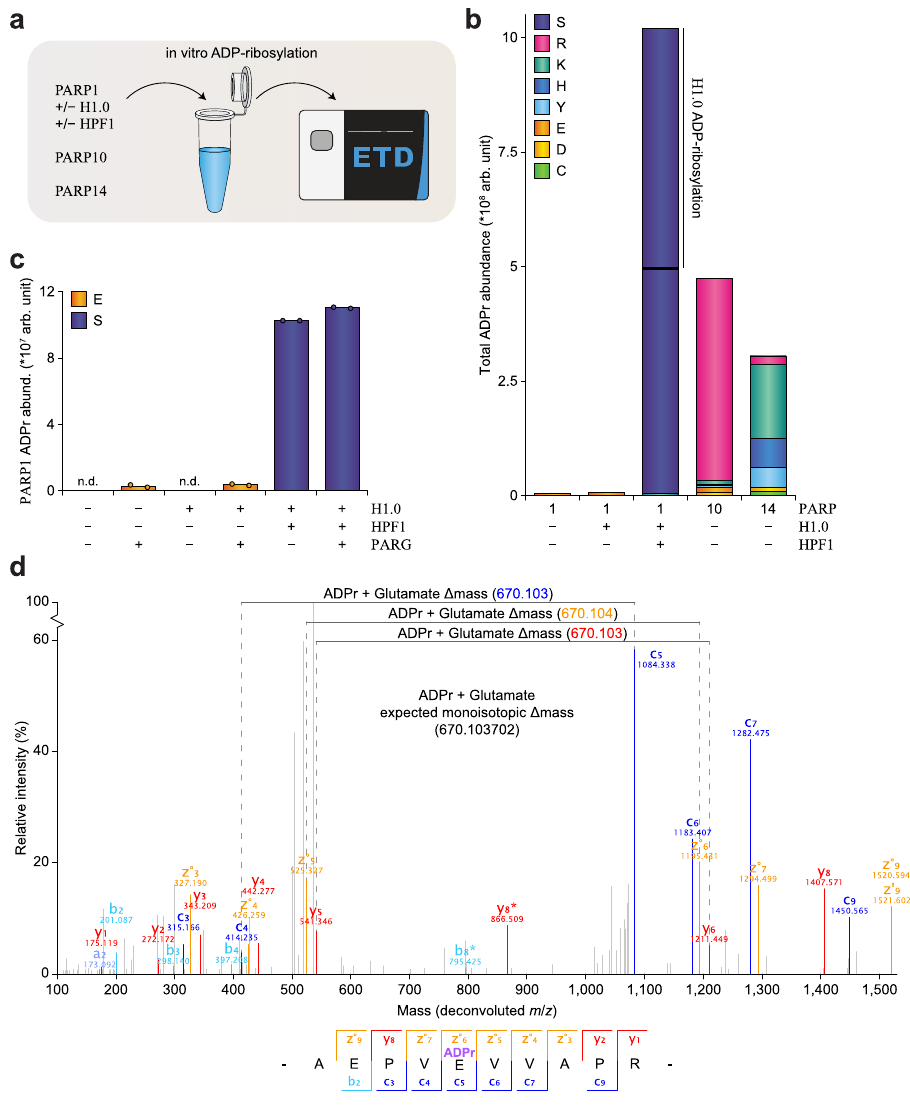
Fig. 1 EThcD analysis of in vitro ADP-ribosylated PARPs. a Overview of the experimental design. Recombinant PARP1, PARP10, or PARP14, were modi fi ed in vitro. For PARP1, the reaction was performed ±H1.0 and ±HPF1. Samples were trypsinized, and afterward mock-treated or treated with PARG, prior to analysis of the peptides by ETD-based MS. b Total abundance distribution of in vitro ADPr-modi fi ed amino acid residues. Abundance values ± PARG were summed. c Average abundance distribution of in vitro auto-modi fi ed residues on PARP1. n = 3 technical replicates. “ n.d. ” not detected, data points not shown in case of n.d. d Fully annotated EThcD MS/MS spectrum, demonstrating con fi dent localization of ADP-ribosylation to Glutamate-491 on PARP1. Light blue; b-ions, dark blue; c-ions, red; y-ions, orange; z-ions, gray; unassigned. Source data are provided as a Source Data fi